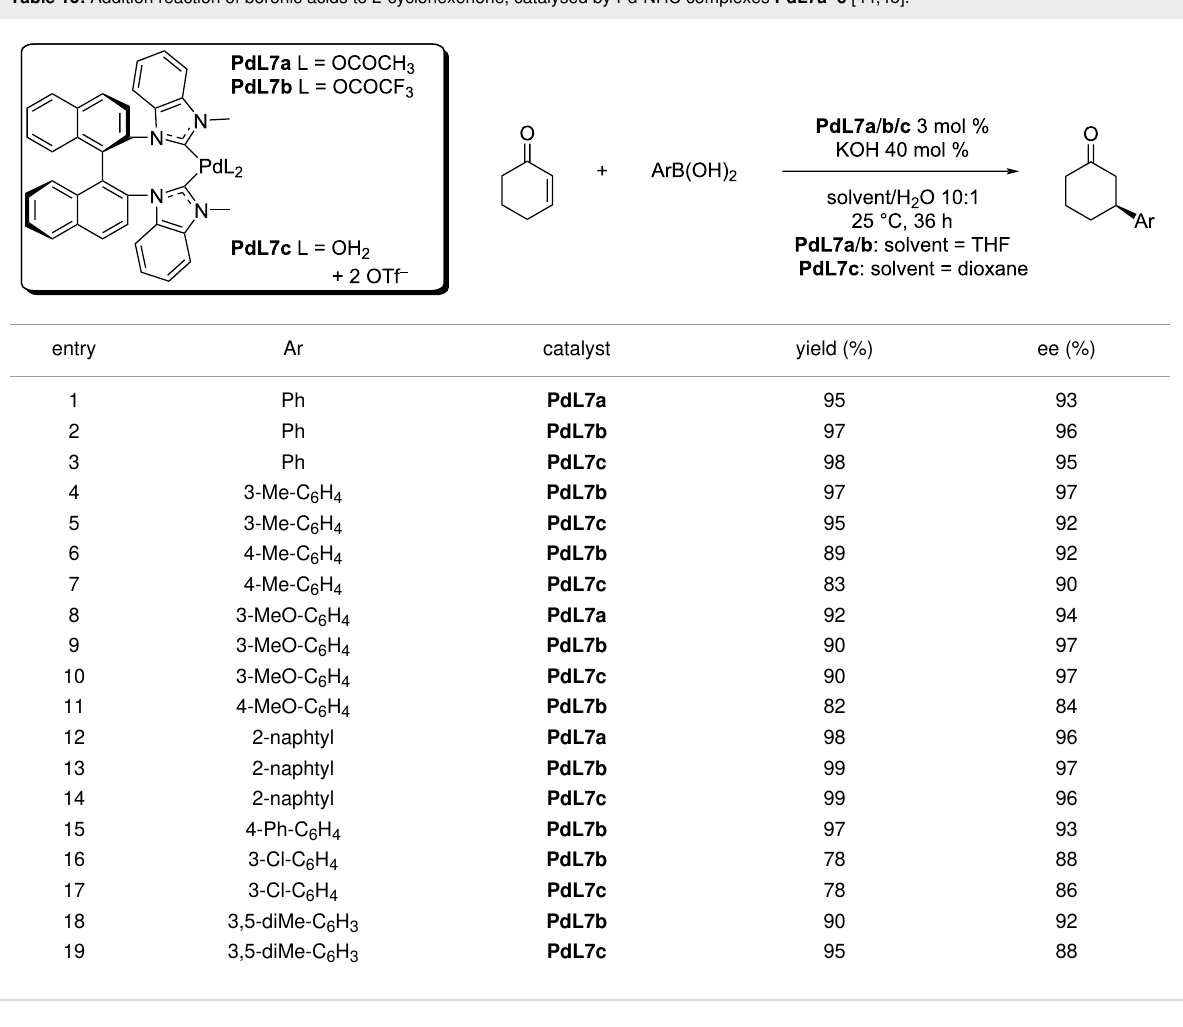
Table 13: Addition reaction of boronic acids to 2-cyclohexenone, catalysed by Pd-NHC complexes PdL7a–c [44,45].